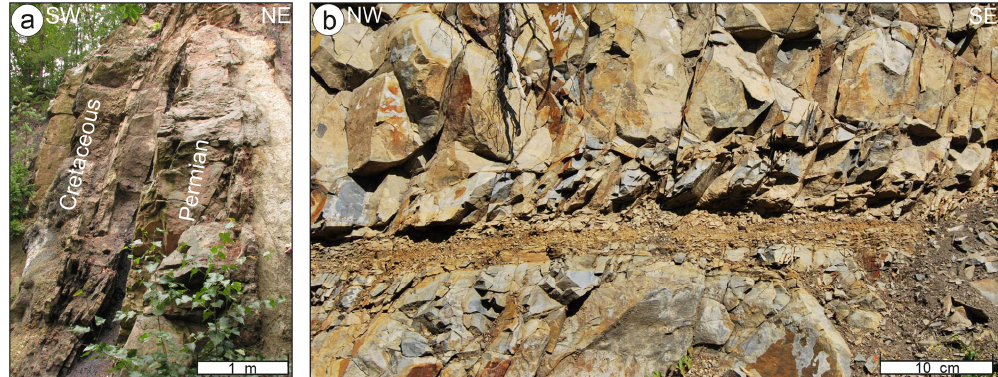
Figure 17. Examples of outcrop-scale brittle structures related to major faults at the SW boundary of the Intra-Sudetic Synclinorium. (a) The Poˇriˇci–Hronov Fault, interpreted as a high-angle reverse structure, near the village of Malé Svatoˇnovice: tectonic contact between nearly vertically dipping Upper Cretaceous sandstones in the SW and the Permian sandstone in the NE. (b) Shallow NW-dipping detachment along the bedding of middle Turonian mudstones and calcareous claystones in a road cut near the village of Lewin Kłodzki, probably related to the NW continuation of the Zieleniec Thrust. Location in Figs. 2 and